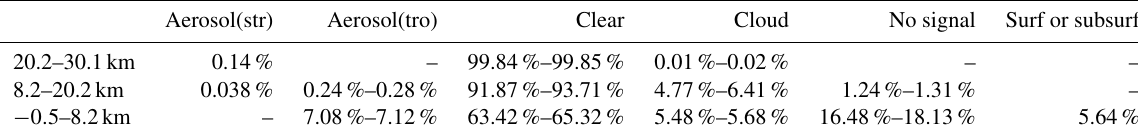
Table 2. Summary of atmosphere condition from 10 to 24 April and from 14 to 29 September 2015.